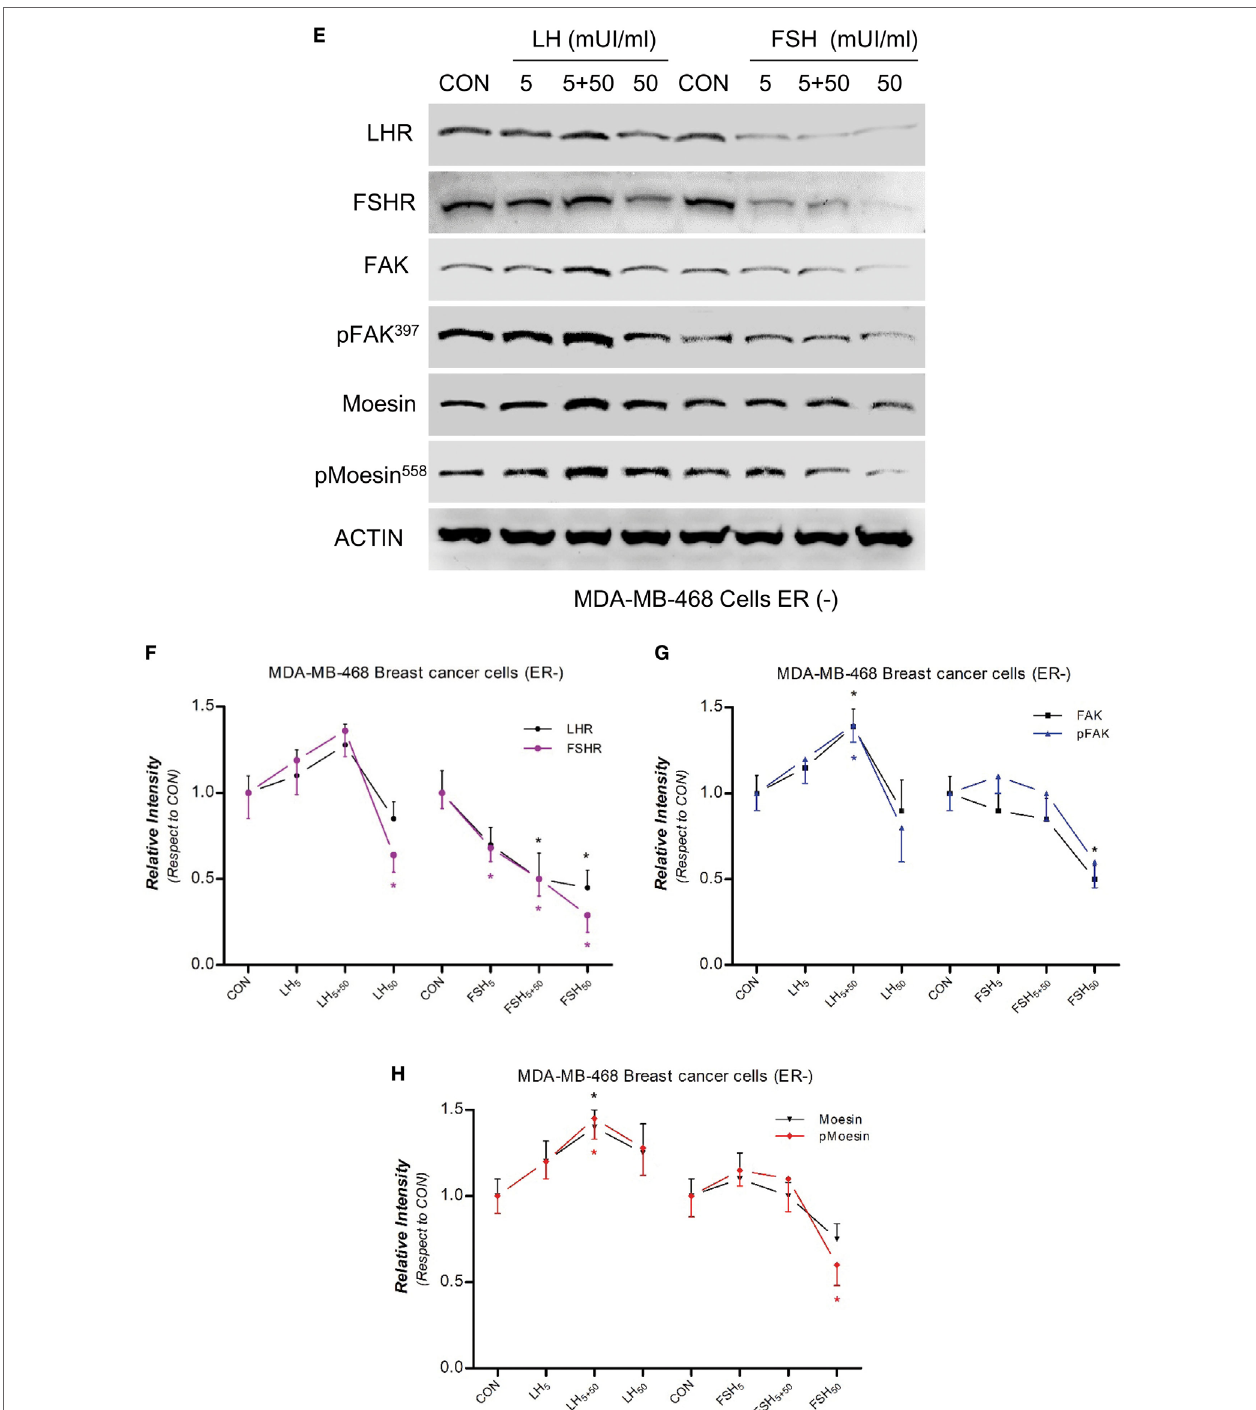
FigUre 1 | Modulatory effects of gonadotropins on breast cancer (BC) cell expression/activation of follicular-stimulating hormone receptor (FSHR), LHR, moesin, and focal adhesion kinase (FAK). Protein extracts from (a) T-47D (estrogen-receptor positive) and (e) MDAMB-468 (estrogen-receptor negative) BC cells treated for 48 h with increasing concentration of LH and follicle-stimulating hormone (FSH) (5, 5 + 50, and 50 mUI/ml) were assayed using western blot analysis for their overall content of LHR, FSHR, moesin, p-Moesin T558 , FAK, p-FAKY 397 , and actin. (B–D,F–h ) LHR, FSHR, moesin, p-Moesin T558 , FAK, p-FAKY 397 densitometry values were adjusted to actin intensity, respectively, then normalized to the control sample. * P < 0.05 vs. corresponding control. The experiments were performed in triplicates and representative images are